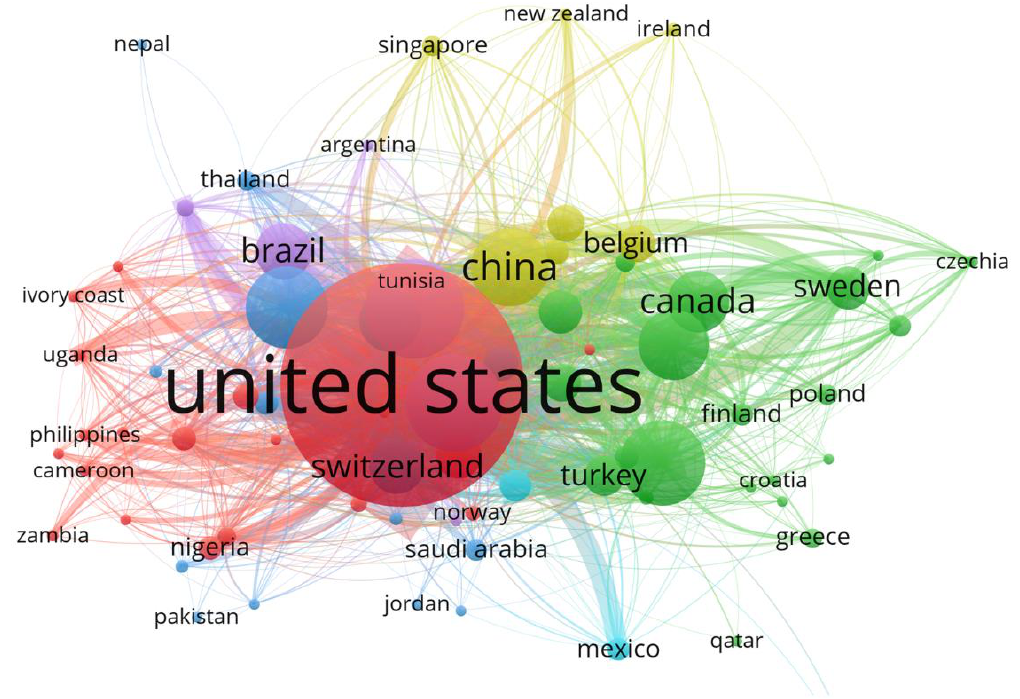
Figure 7. Outstanding countries contributing to rubella virus research.